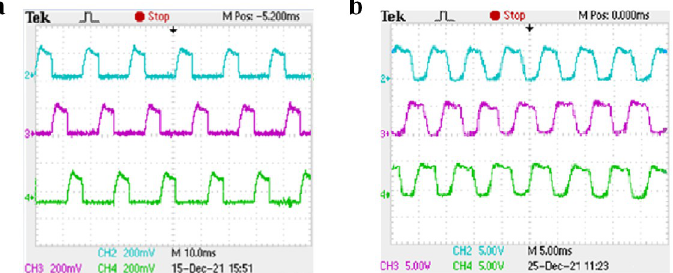
Fig 16. Three-phase current waveforms for normal operation. (a) The speed is 500 r/min. (b) The speed is 1000 r/ min.